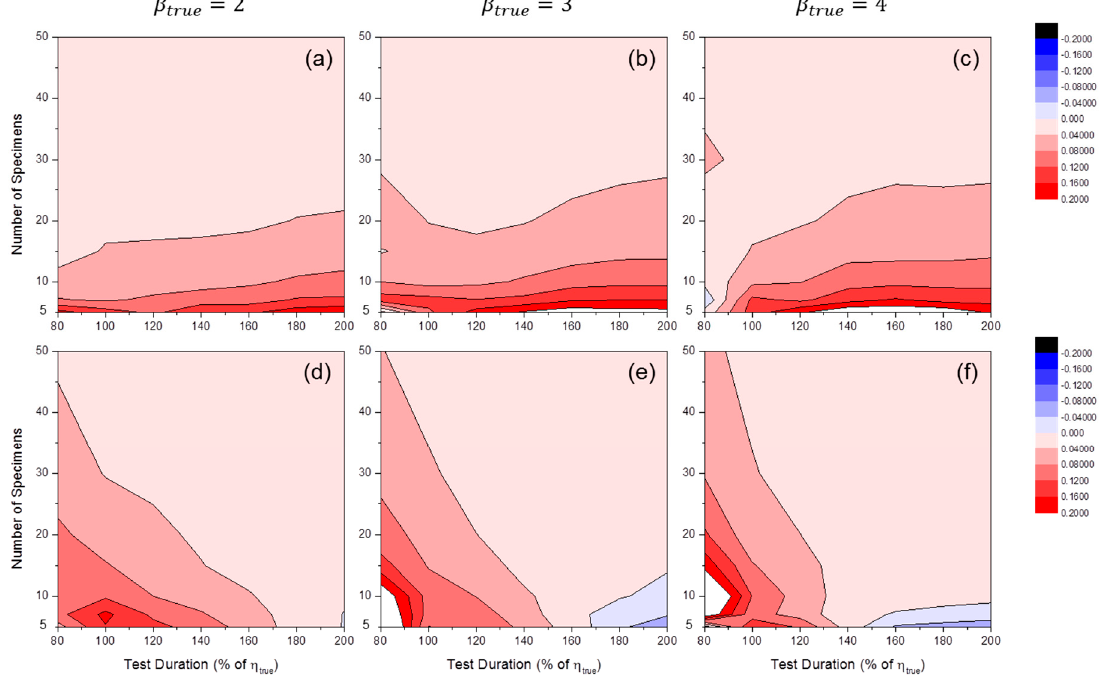
Figure 12. Distributions of SE (cid:2873)(cid:2868)% ((cid:2010)(cid:4632) (cid:3014)(cid:3013)(cid:3006) ) at: ( a ) (cid:2010) (cid:3047)(cid:3045)(cid:3048)(cid:3032) = 2 ; ( b ) (cid:2010) (cid:3047)(cid:3045)(cid:3048)(cid:3032) = 3 ; and ( c ) (cid:2010) (cid:3047)(cid:3045)(cid:3048)(cid:3032) = 4 and Figure 12. Distributions of SE 50% p ˆ β MLE q at: ( a ) β true “ 2; ( b ) β true “ 3; and ( c ) β true “ 4 and SE (cid:2873)(cid:2868)% ((cid:2010)(cid:4632) (cid:3014)(cid:3019)(cid:3019) ) at: ( d ) (cid:2010) (cid:3047)(cid:3045)(cid:3048)(cid:3032) = 2 ; ( e ) (cid:2010) (cid:3047)(cid:3045)(cid:3048)(cid:3032) = 3 ; and ( f ) (cid:2010) (cid:3047)(cid:3045)(cid:3048)(cid:3032) = 4 (censoring interval: 20% of (cid:2015) (cid:3047)(cid:3045)(cid:3048)(cid:3032) ). SE 50% p ˆ β MRR q at: ( d ) β true “ 2; ( e ) β true “ 3; and ( f ) β true “ 4 (censoring interval: 20% of η true